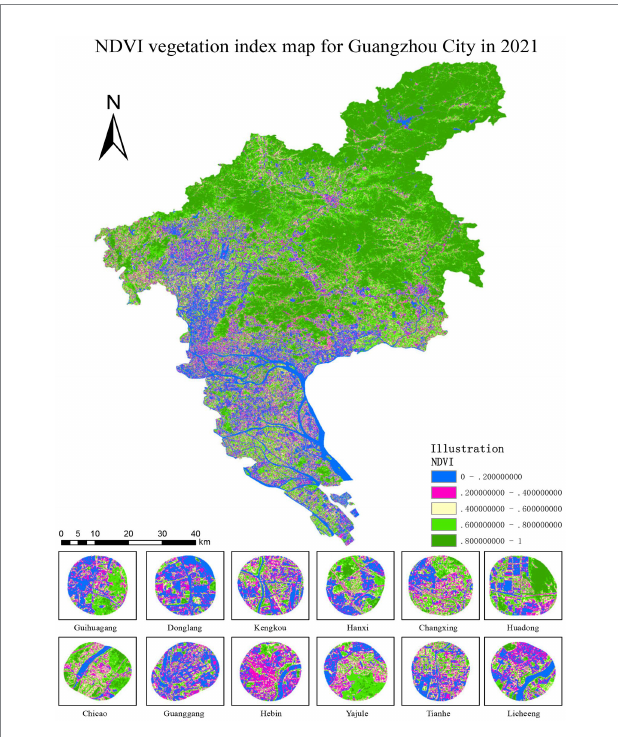
FIGURE 3 NDVI normalized difference vegetation index (NDVI) map for Guangzhou in